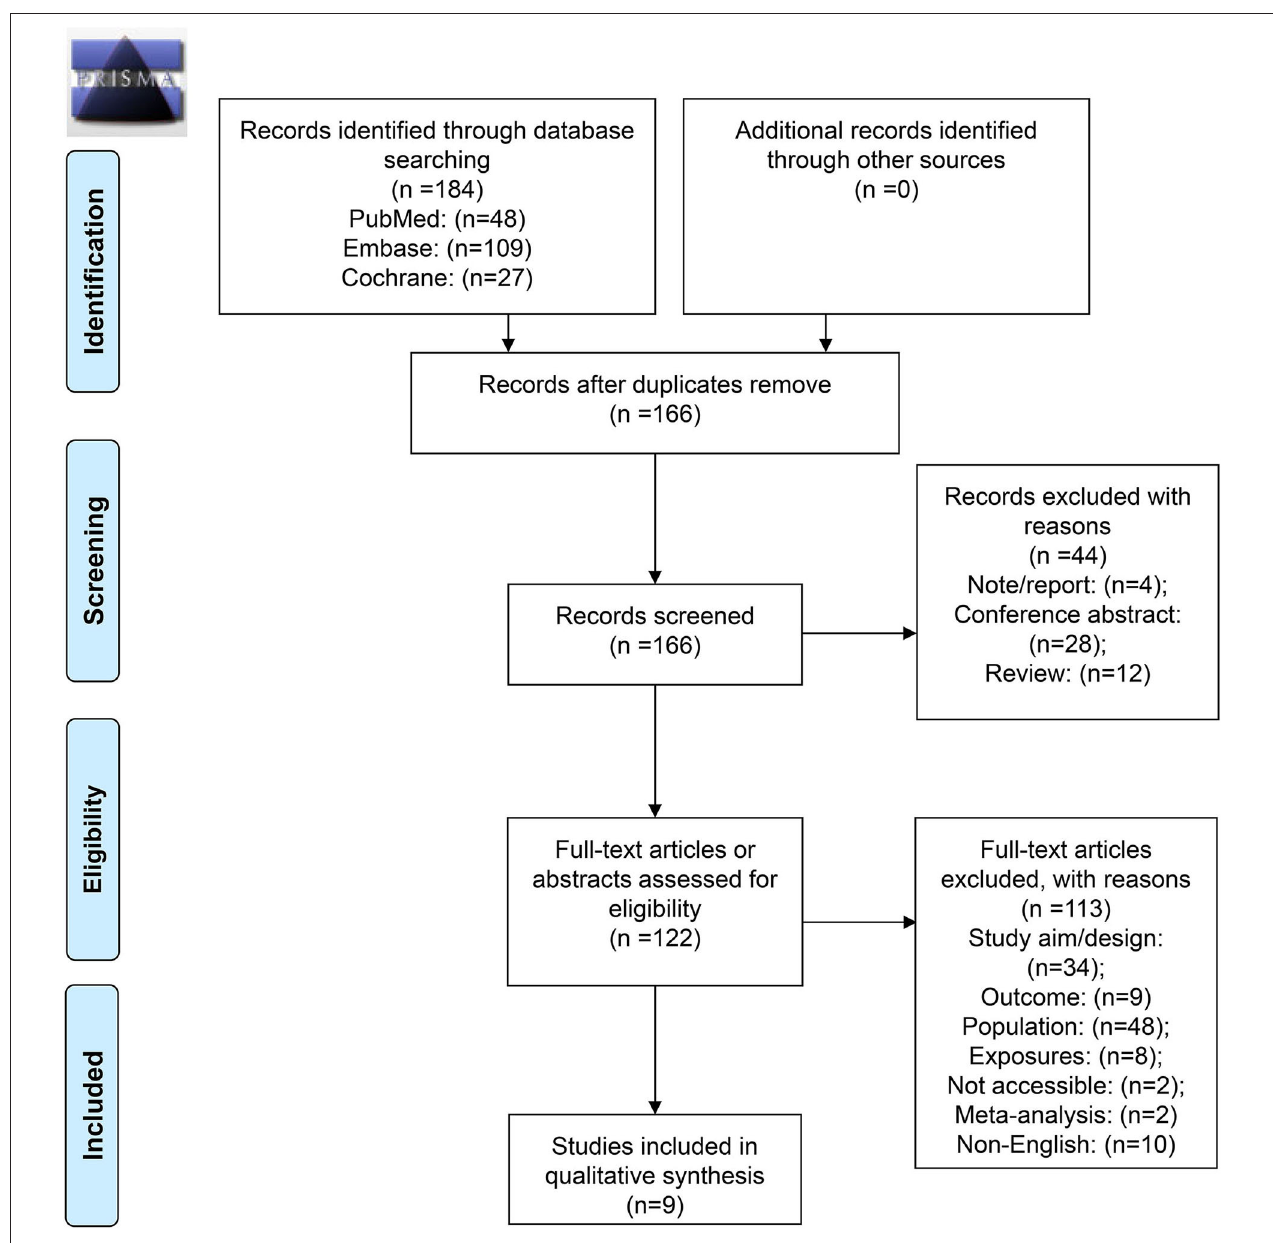
FIGURE 1 | Preferred reporting items for systematic reviews and meta-analyses (PRISMA) 2009 flow diagram.